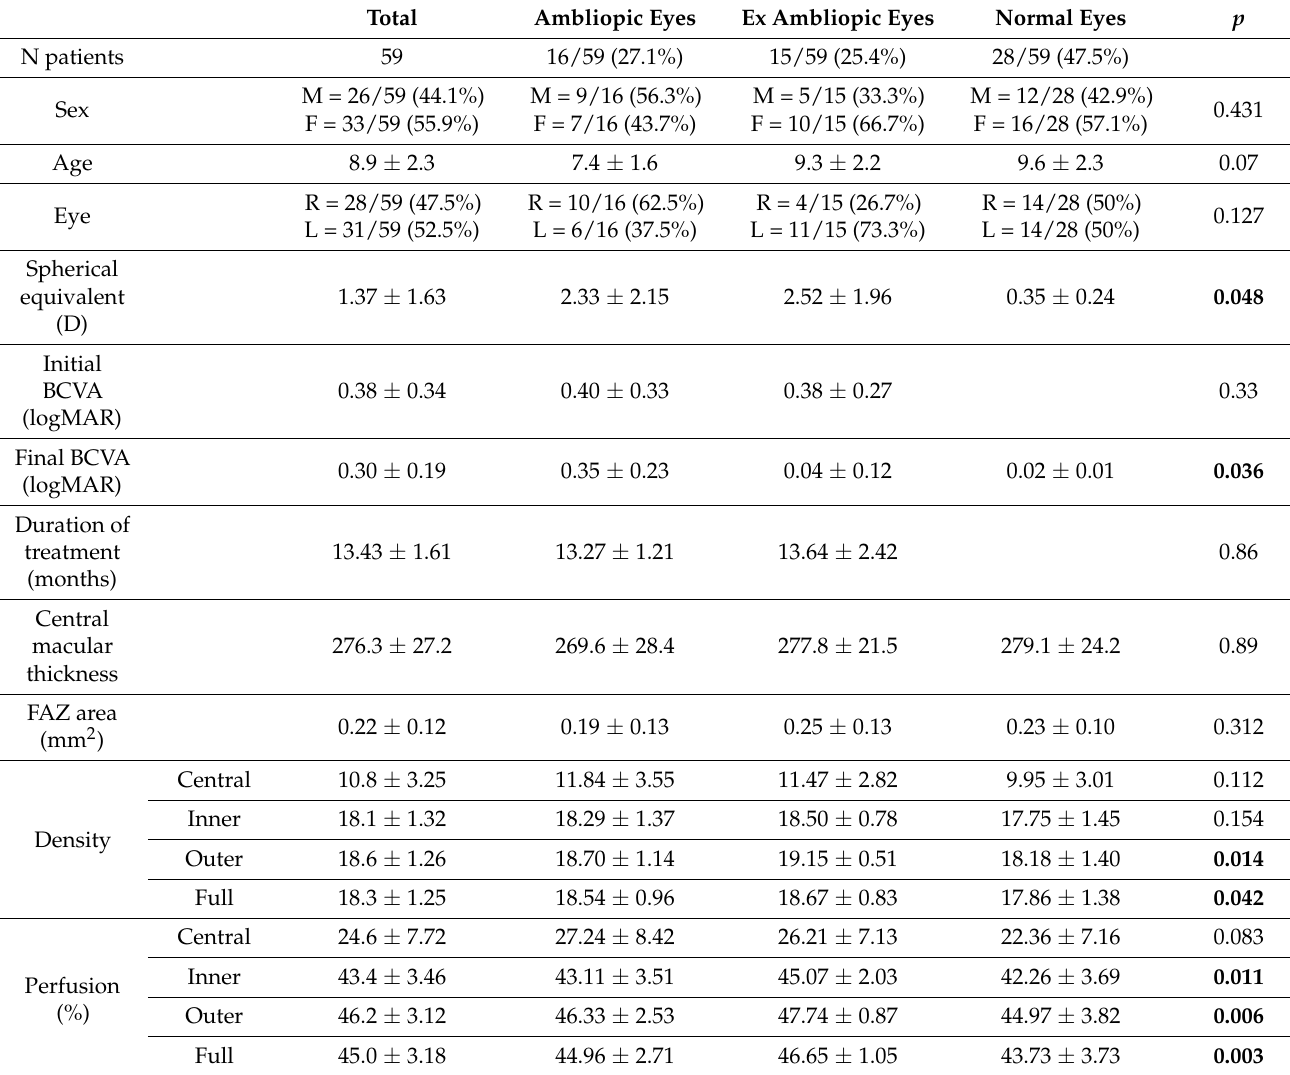
Table 1. Results of multivariate analysis comparing general and ophthalmic characteristics among groups. As concerns the variables “sex” and “eye”, result refer to Chi 2 statistics. p values displayed on the last column report the output of post hoc analysis of the analyzed correlations. BCVA = best-corrected visual acuity; FAZ = foveal avascular zone, M = male, F = female, R = right, L = Left. Bold values denote statistically significance difference between the